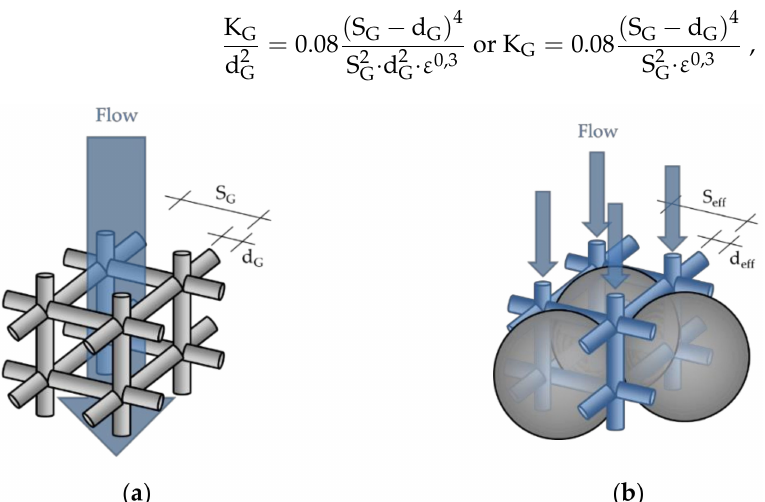
Figure 11. ( a ) Simple cubic 3D arrangement of cells in a porous medium; ( b ) 3D arrangement of the capillaries between the particles; S G : Centric distance of the non-permeable part of the lattice; d G : Diameter of the lattice bars; S eff : Centric distance of the permeable capillaries; d eff : Diameter of the permeable capillaries.